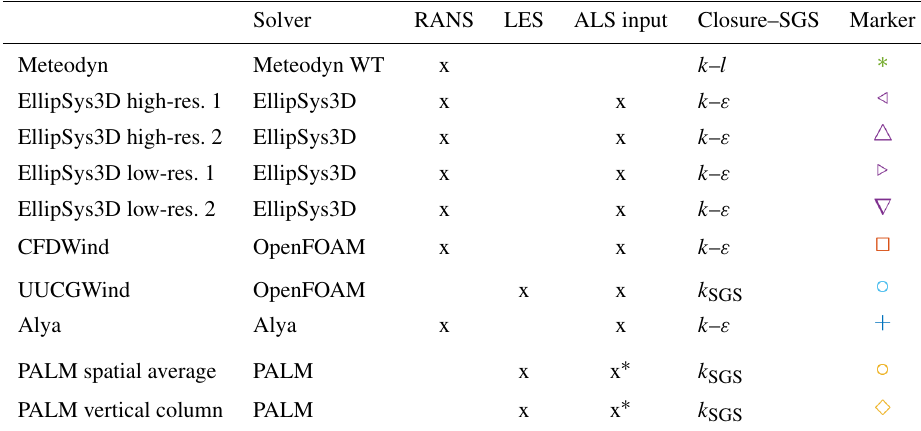
Table 1. Overview of the models used and the model family. Solver RANS LES ALS input Closure–SGS Marker Meteodyn Meteodyn WT EllipSys3D high-res. 1 EllipSys3D EllipSys3D high-res. 2 EllipSys3D low-res. 1 CFDWind OpenFOAM UUCGWind OpenFOAM x x k SGS Alya Alya x x k – ε PALM spatial average PALM x x ∗ k SGS PALM vertical column PALM